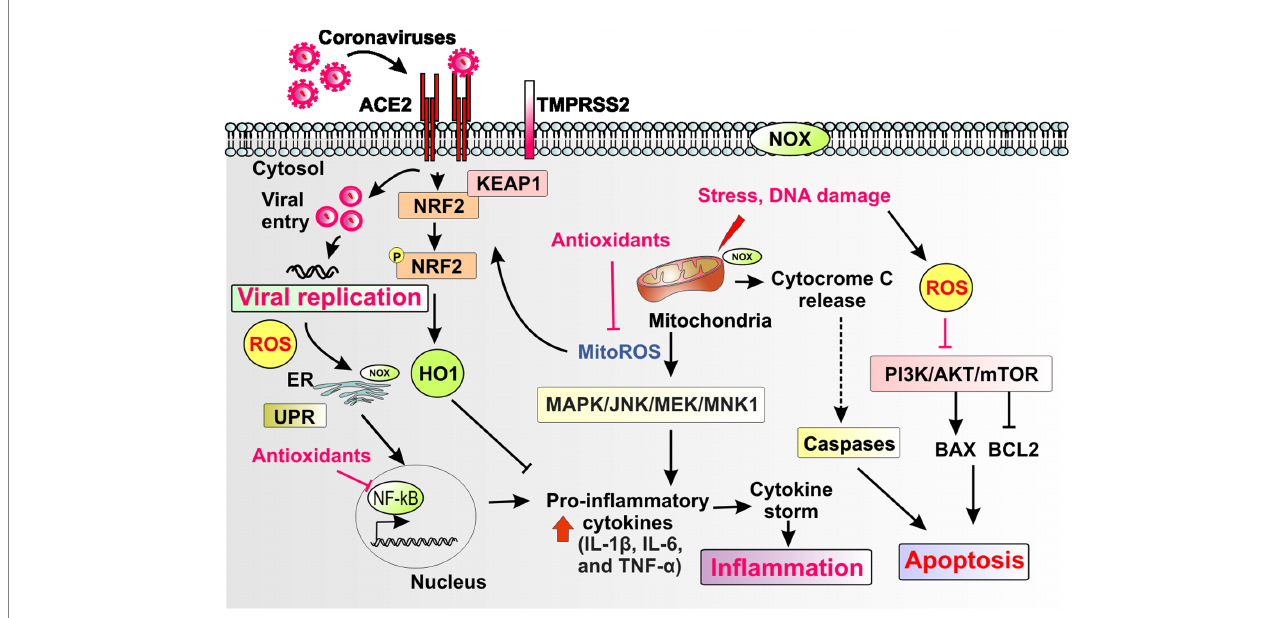
FIGURE 2 Schematic representation of redox pathways that contribute to viral replication, inflammation, and apoptosis during coronavirus infection. Coronaviruses bind to the ACE2 receptor and replicate through host proteases such as TMPRSS2 and by hijacking cytosolic cellular machinery such as the mitochondria and the endoplasmic reticulum (ER), which engages the unfolded protein response (UPR). The plasma membrane, the ER and mitochondria harbor different isoforms of the NADPH oxidase (NOX) enzyme. Coronaviruses induce cellular oxidative stress with generation of reactive oxygen species (ROS) and mitochondrial ROS (mito-ROS) and impairment of stress-inducible, antioxidant, anti-inflammatory and antiviral responses such as the Nrf2 pathway and other key downstream mediators such as Heme oxygenase-1 (HO-1). Mito-ROS induce downstream signaling pathways such as MAPK, JNK, MEK/MNK1 that induce both viral replication and proinflammatory pathways such as induction of cytokines (e.g., IL-1b, IL-6, and TNF-a). Mito-ROS, ROS and ER stress response induce the proinflammatory pathway NF- κ B. ROS and mito-ROS also induce apoptosis through alterations in apoptotic pathways such as PI3K/AKT, mTOR and induction of mitochondrial apoptosis. Collectively, redox mediated pathways that drive viral replication, inflammation and apoptosis contribute to cell and tissue damage that drive end organ disease in coronavirus infection. Endogenous antioxidant host pathways and exogenous therapeutic antioxidants could attenuate redox mediated pathways that drive pathogenesis of coronavirus